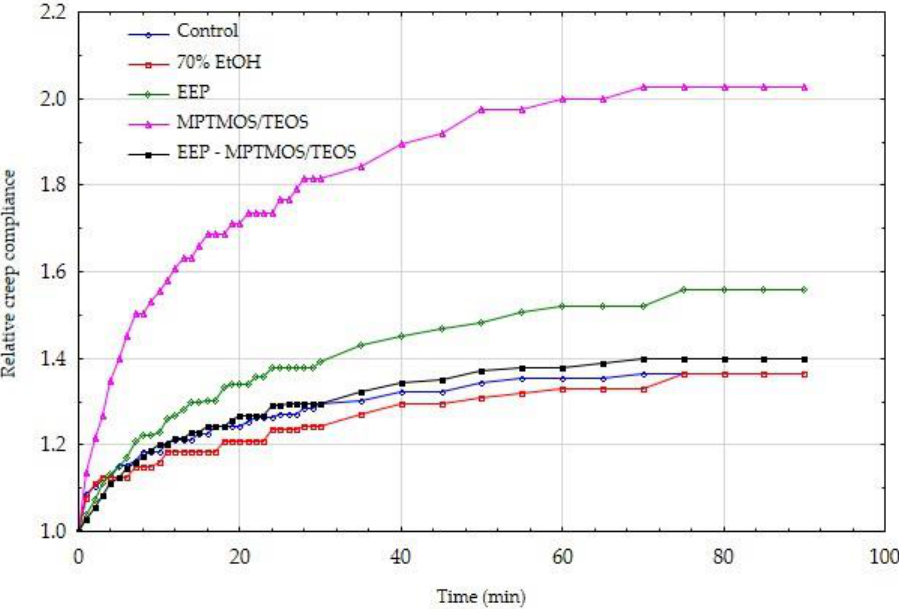
Figure 6. Relative creep compliance of wet wood, protected by various means.